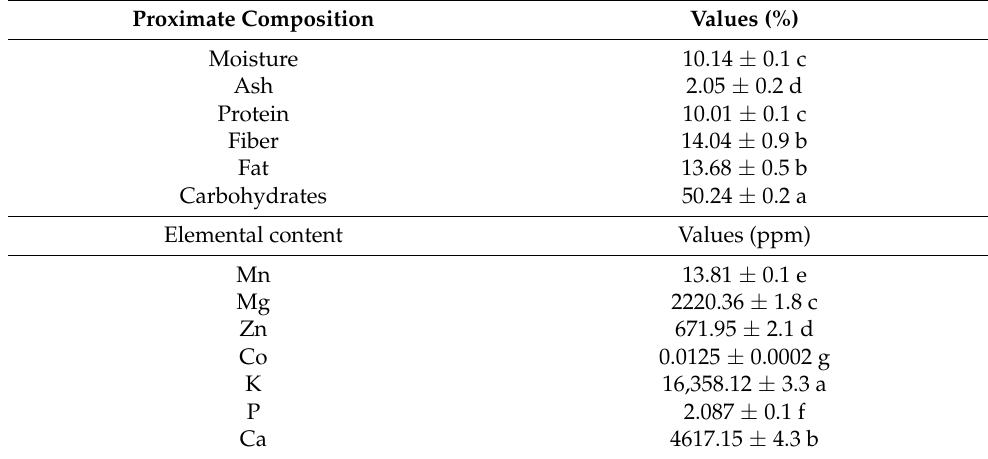
Table 1. Proximate analysis of the Delonix regia flower (on a dry weight